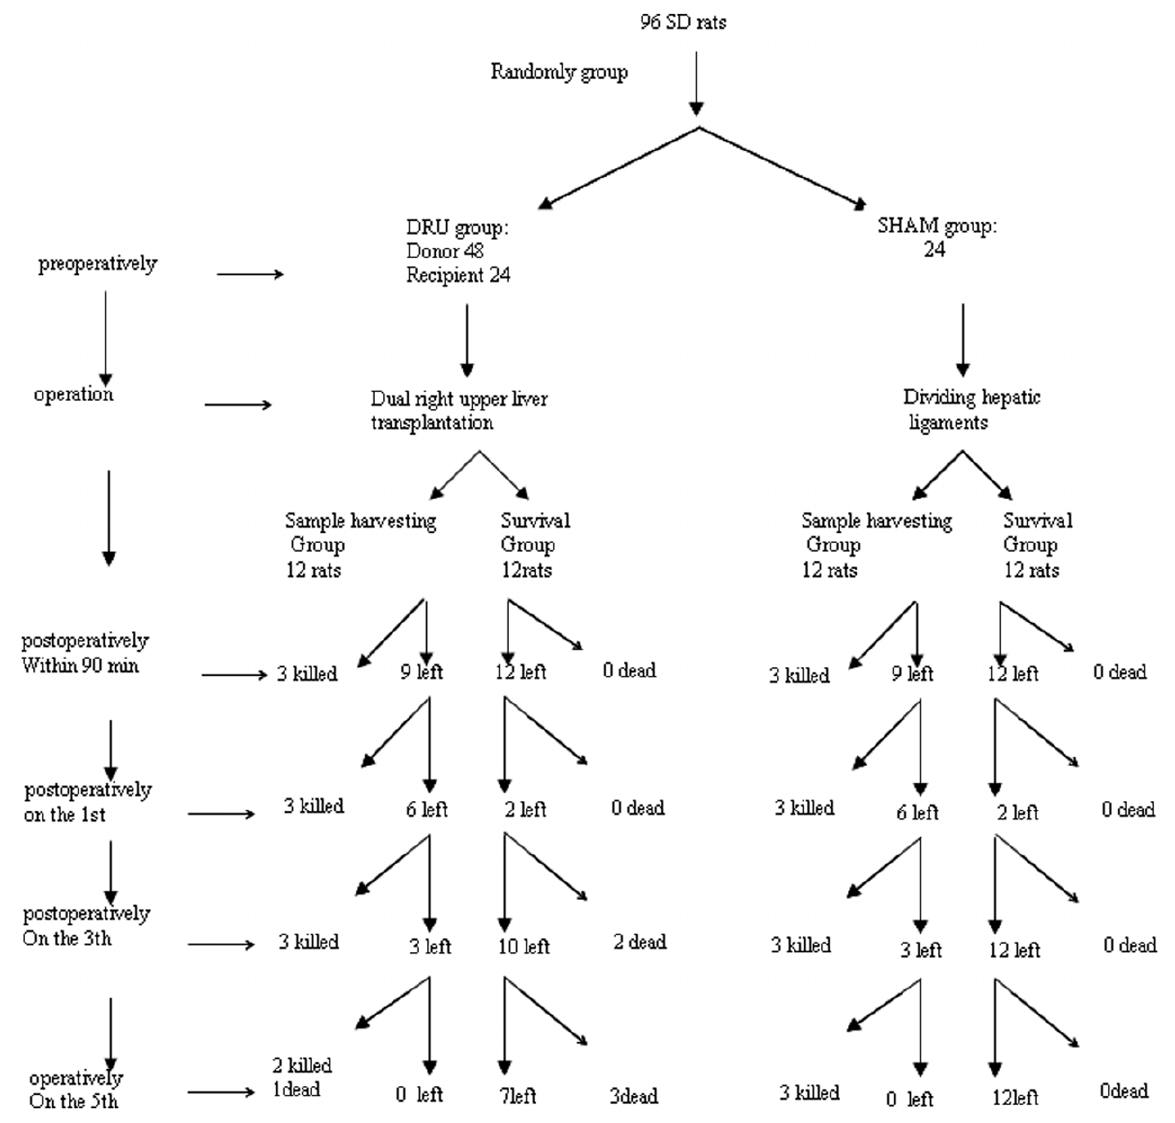
Figure 6. Experiment group and animal number.